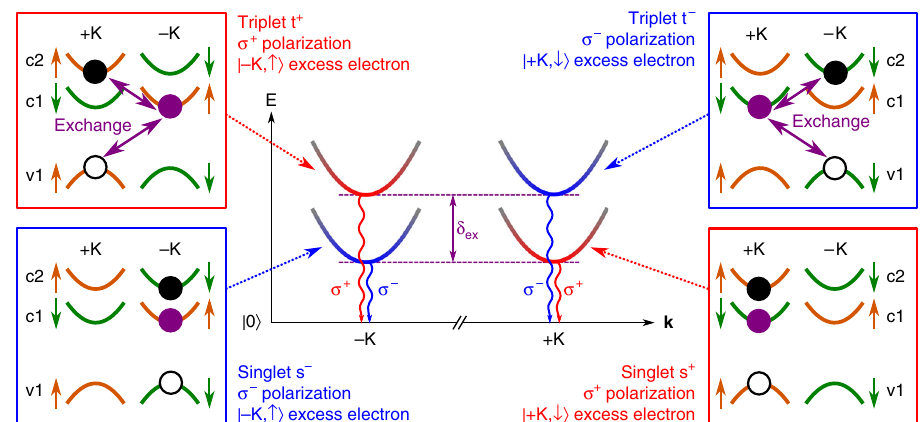
Fig. 1 Scheme of singlet and triplet trions in WSe 2 . Generalized dispersion relations E ( k ), where k is the wavevector of the excess electron, of the four optically bright ground state negative trions in monolayer WSe 2 , following the convention established in refs. 20,25,26 . Side panels illustrate the spin-valley con fi gurations of the constituent carriers of each trion variety. v1 is the topmost spin-subband within the valence band, while c1 (c2) is the lower (upper) energy spin-orbit split conduction band. Based on optical selection rules, the black electron (black fi lled circle) and hole (black empty circle) are the recombining pair, while the purple electron (purple fi lled circle) is excess and occupies band c1. Orange (green) conduction and valence band states are spin up (down). Red (blue) colours denote σ + ( σ − ) helicity of the bright transition. The trion states are labelled X Y where X = s, t for singlet or triplet, Y = + , − for σ + or σ − emission helicity. Purple arrows indicate the intervalley Coulomb exchange interaction, present only in triplet trions, which raises the energy of the triplets by an amount δ ex above the singlets. This energy gap gives rise to the trion fi ne structure in